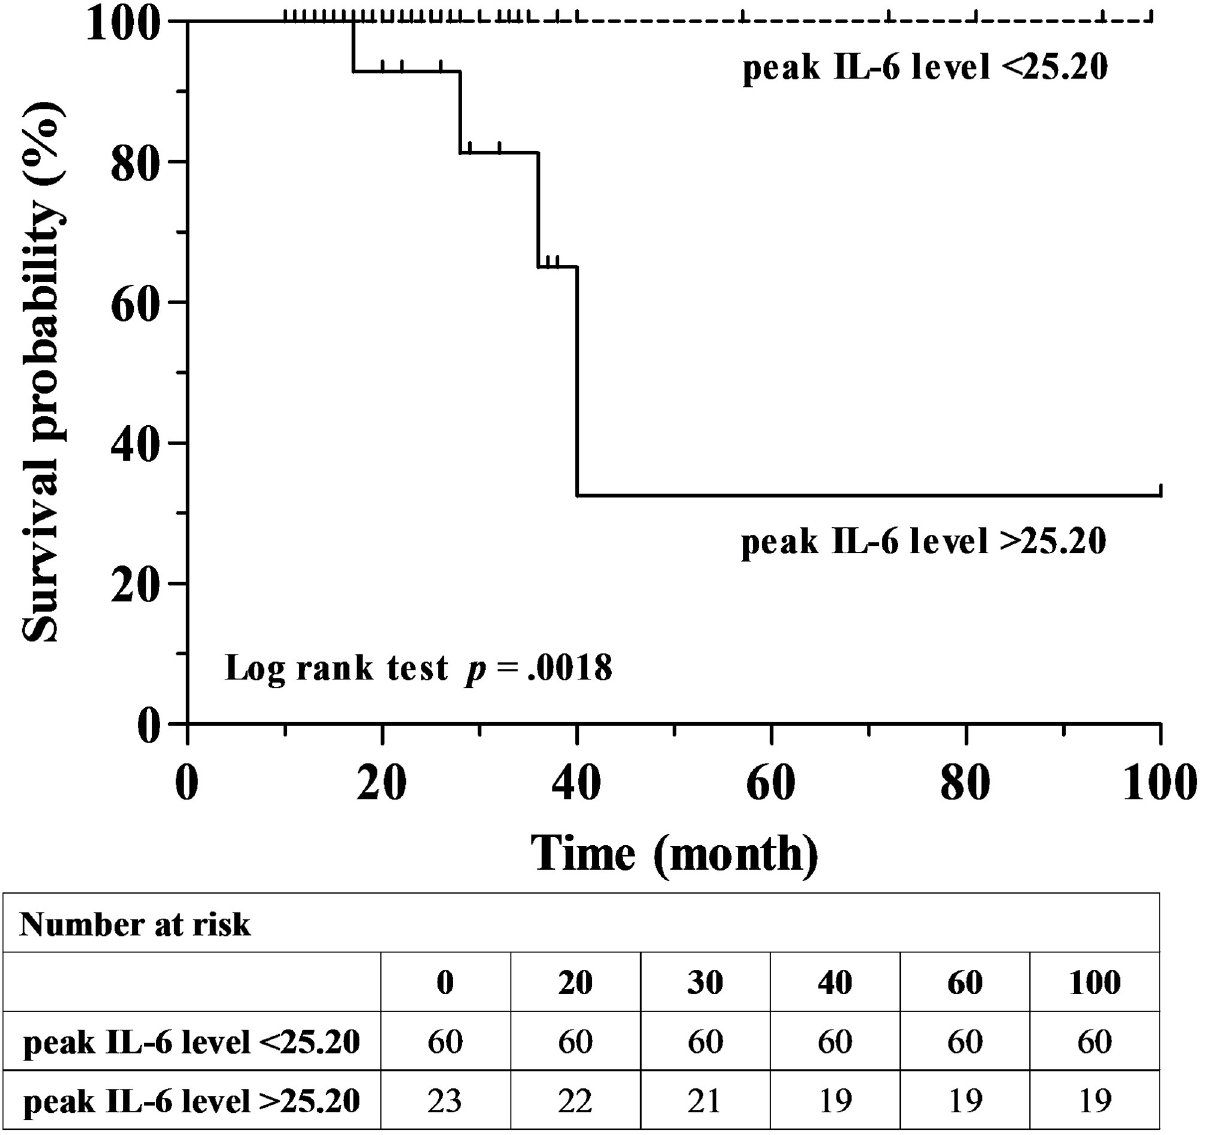
Fig 3. Comparison of Kaplan–Meier survival curves between high and low levels of IL-6. IL-6, interleukin 6.